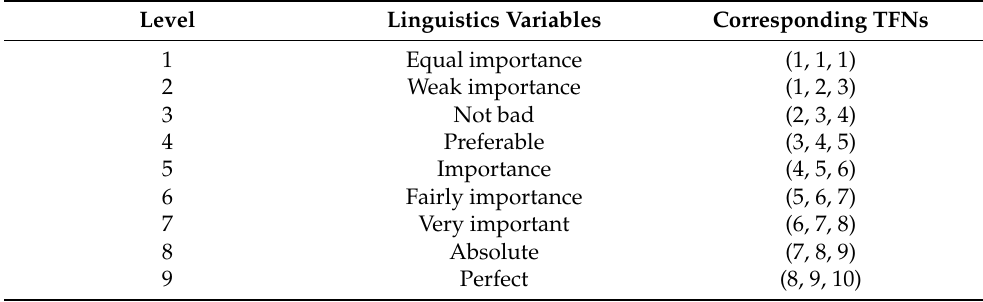
Table 3. Linguistic variable values in FAHP